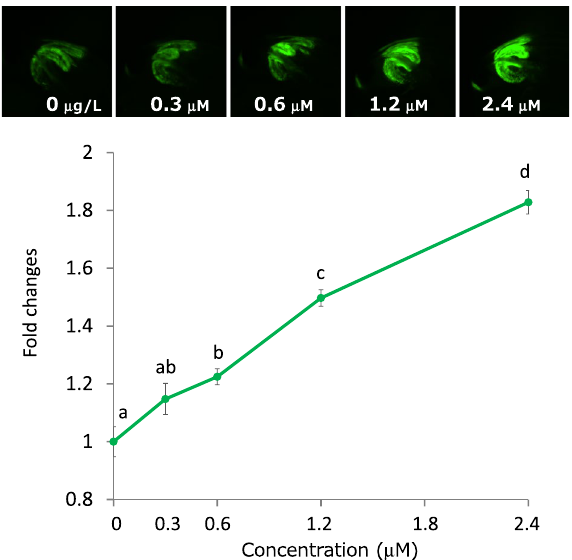
Figure 4. GFP expression changes after ZnCl 2 exposure for 1 h. Top: representative images of hepatopancreas exposed to ZnCl 2 for 1 h. Bottom: GFP expressions were quantified and fold changes vs. 0 mg/L fluorescence intensity were calculated. Five daphniids were exposed in 10 mL of ADaM for 1 h. Fold changes vs. unexposed control were plotted. N = 5; ** p < 0.01 (t-test).